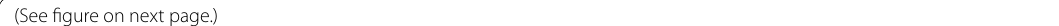
Fig. S1h, i) and referring to published data (Additional file 1: Table S2) (Ito et al. 2013; Hellström and Mattila